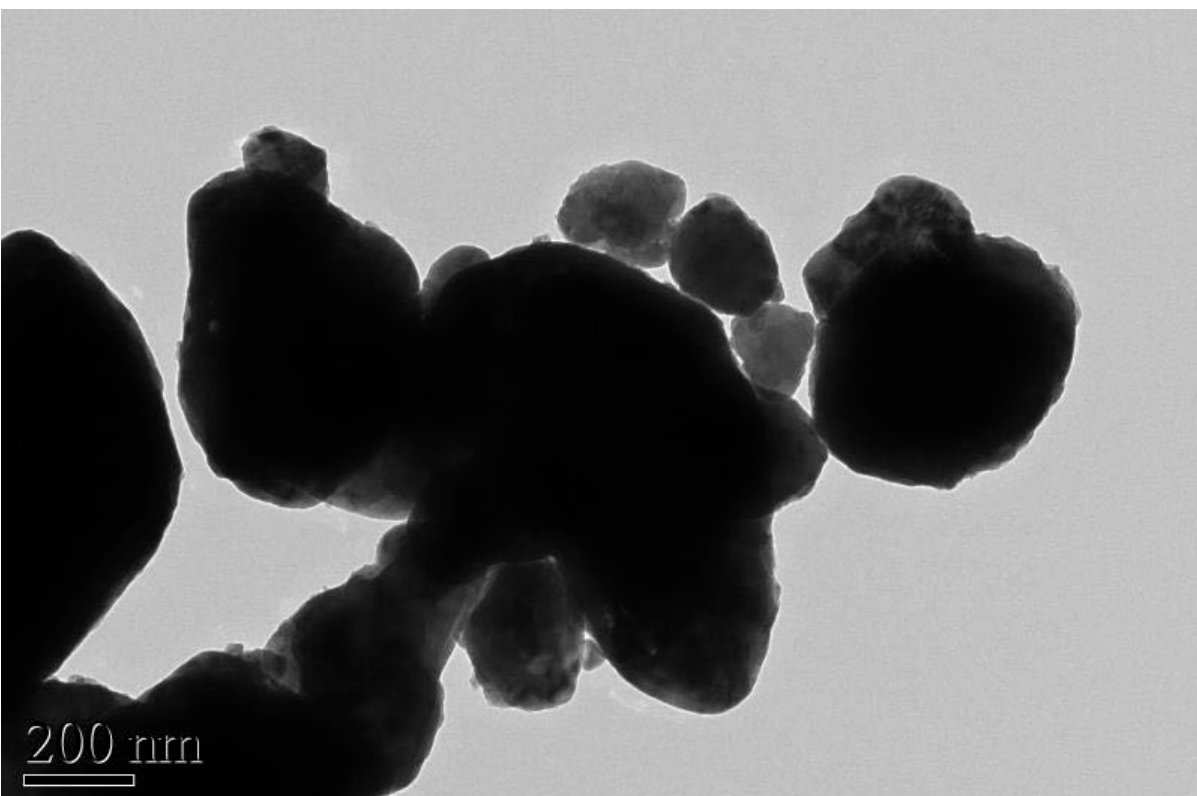
Figure 10. TEM image of In 2 CdO 4 /Y 2 SmSbO 7 heterojunction.